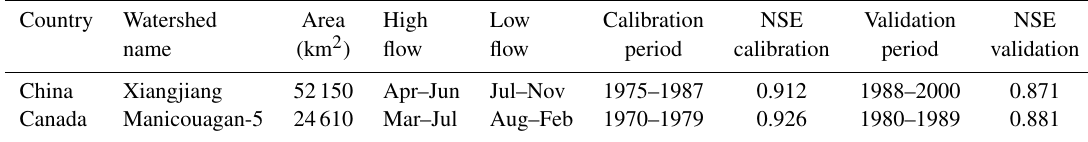
Table 2. Nash–Sutcliffe efficiency (NSE) of the hydrological model in the calibration and validation periods. Country Watershed Area High Low Calibration NSE Validation NSE name (km 2 ) flow flow period calibration period